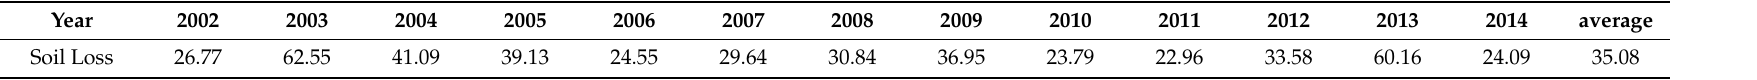
Table 2. The soil loss from 2002 to 2014 in the Wangjiagou agricultural watershed (t · ha − 1 · year − 1 ).